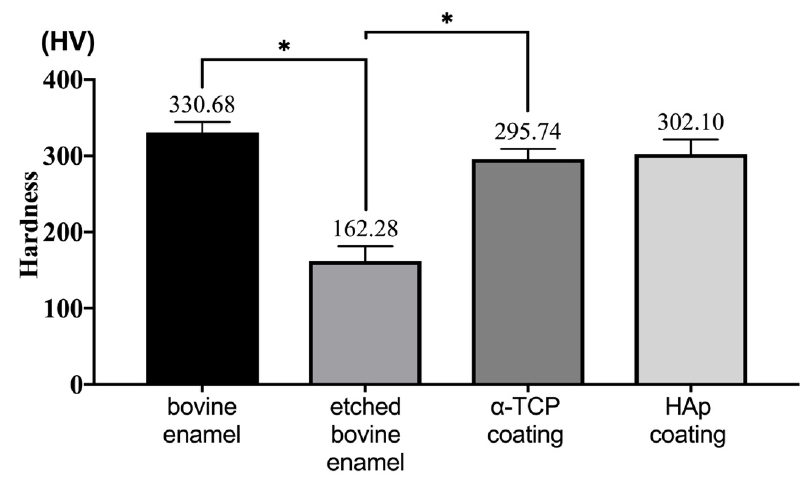
Figure 7. Comparison of the hardness of the bovine dental enamel, etched bovine enamel (specimens), specimens with α‐ TCP sheet, and specimens with hydroxyapatite coating ( n = 30). * p < 0.05.